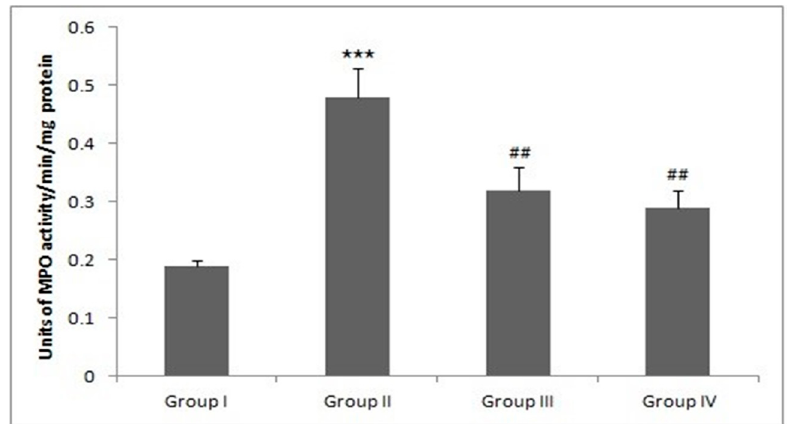
Figure 9. Effect of piperine and DMH-administered group on MPO levels. In DMH-administered group-II, the MPO levels were significantly increased ( *** p < 0.001) as compared to control group-I. Treatment with piperine significantly (30 and 60 mg / kg b. wt.) attenuated MPO levels in group III ( ## p < 0.05) and group IV ( ## p < 0.01) as compared to group-II ( n = 10).